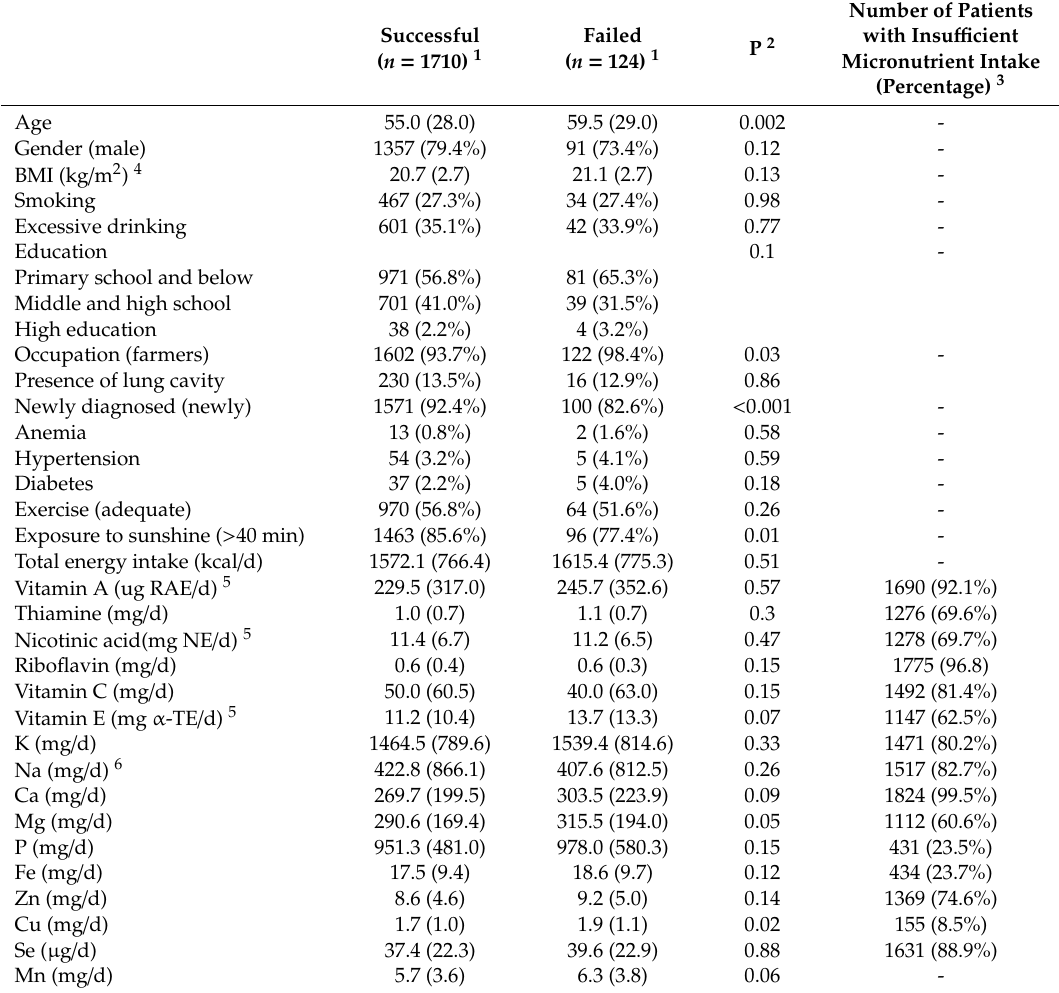
Table 1. Basic characteristics at study entry and dietary micronutrient intake after two weeks’ antituberculosis treatment for the included 1834 tuberculosis